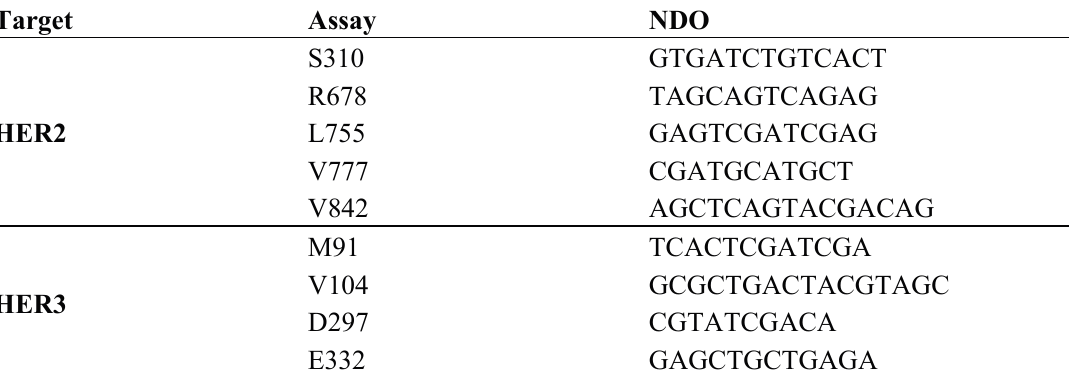
Table 2. Nucleotide dispensation orders of HER2 and HER3